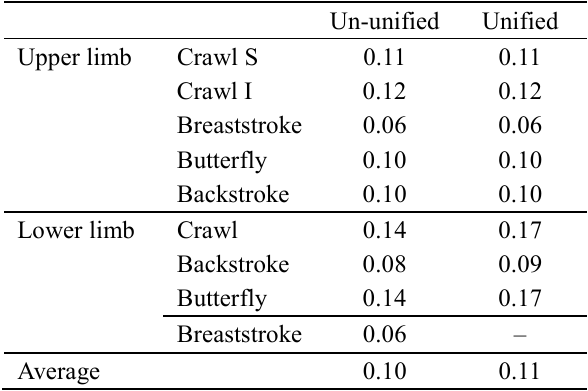
Comparison of precision, P , between simulations with un-unified and unified coefficients Un-unified Unified